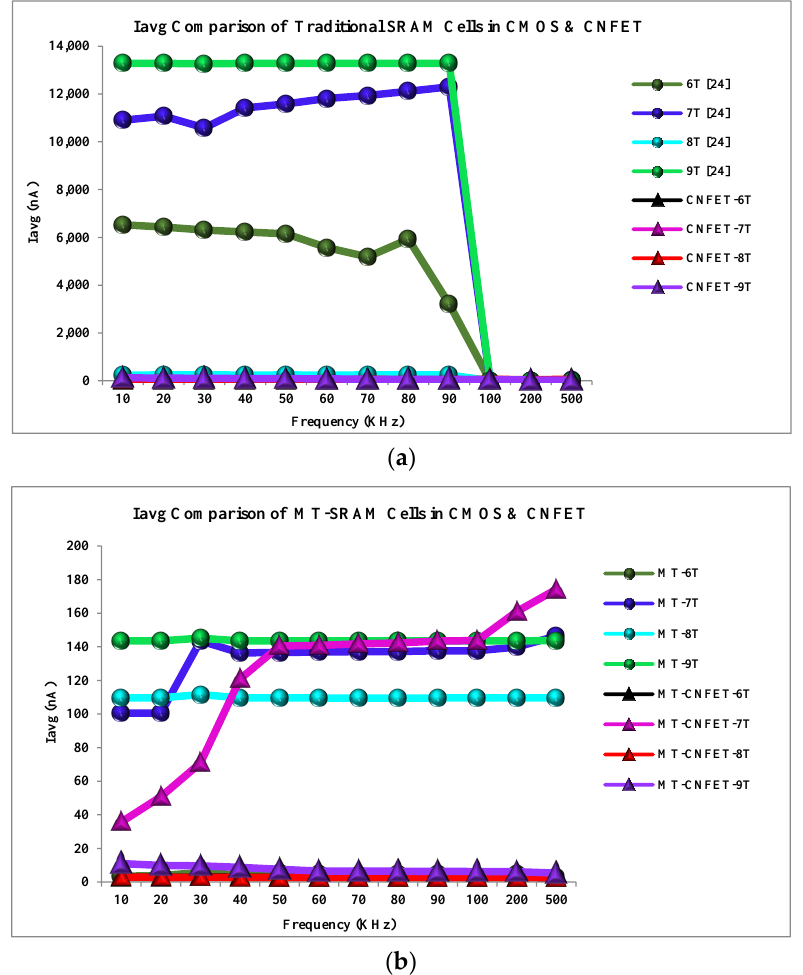
Figure 12. ( a ) Iavg Comparison of Traditional SRAM Cells in CMOS and CNFET. ( b ) Iavg Comparison of Proposed MT - SRAM Cells in CMOS and CNFET. Table 5. Iavg Improvement (%)–CNFET 6T SRAM Cell vs. Other SRAM Cells.